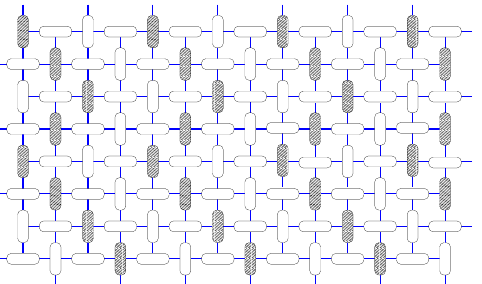
Figure 19: Zigzag-like configuration for the 1 / 4-plateau